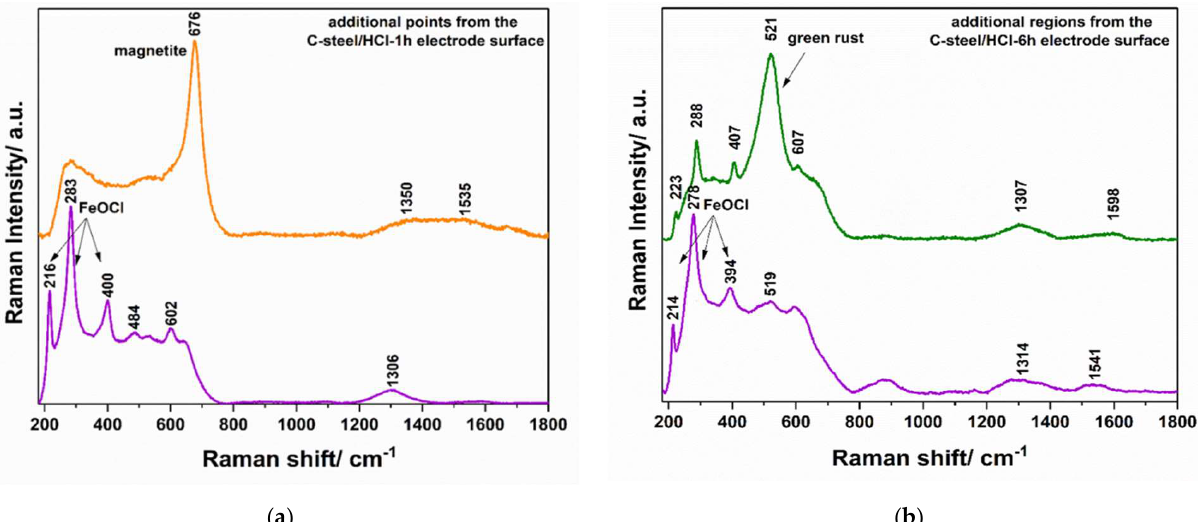
Figure 11. Raman spectra recorded for various additional regions of the C-steel after 1 h ( a ) and 6 h ( b ) exposure to 1 M HCl solution. ( b ) exposure to 1 M HCl